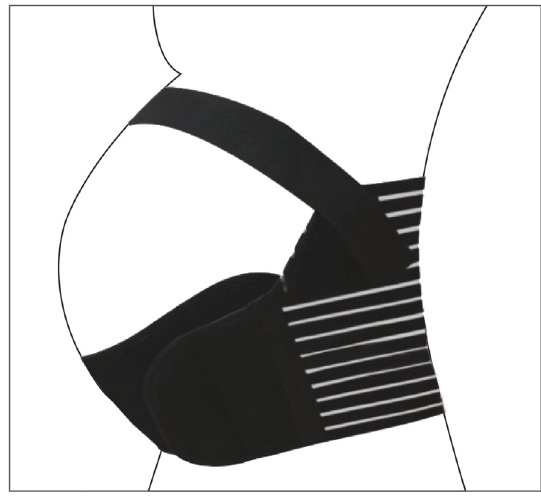
Figure 2: The loving comfort back support.